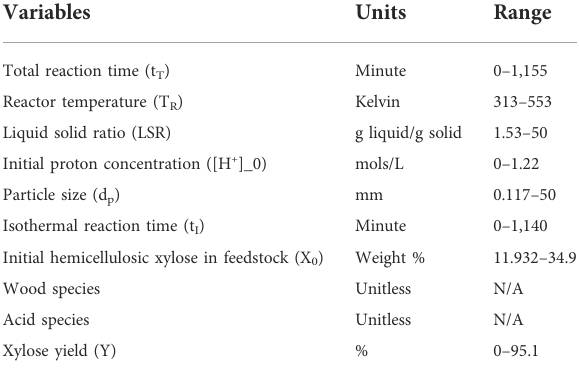
TABLE 1 Collected variables and their ranges for each experimental data